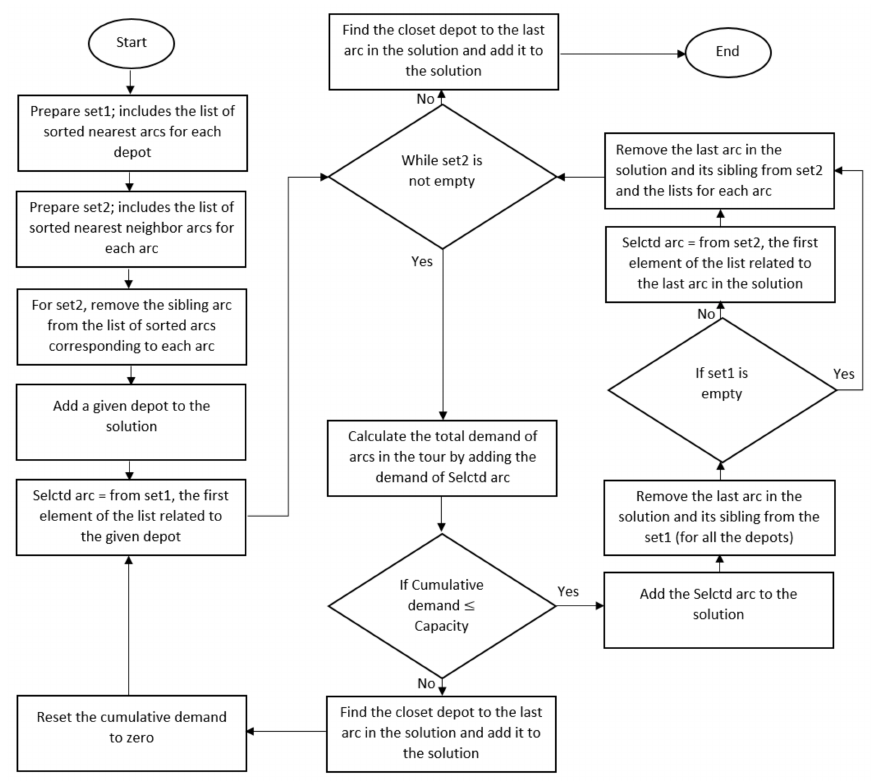
Figure 4. An overview of the process of generating an initial solution.